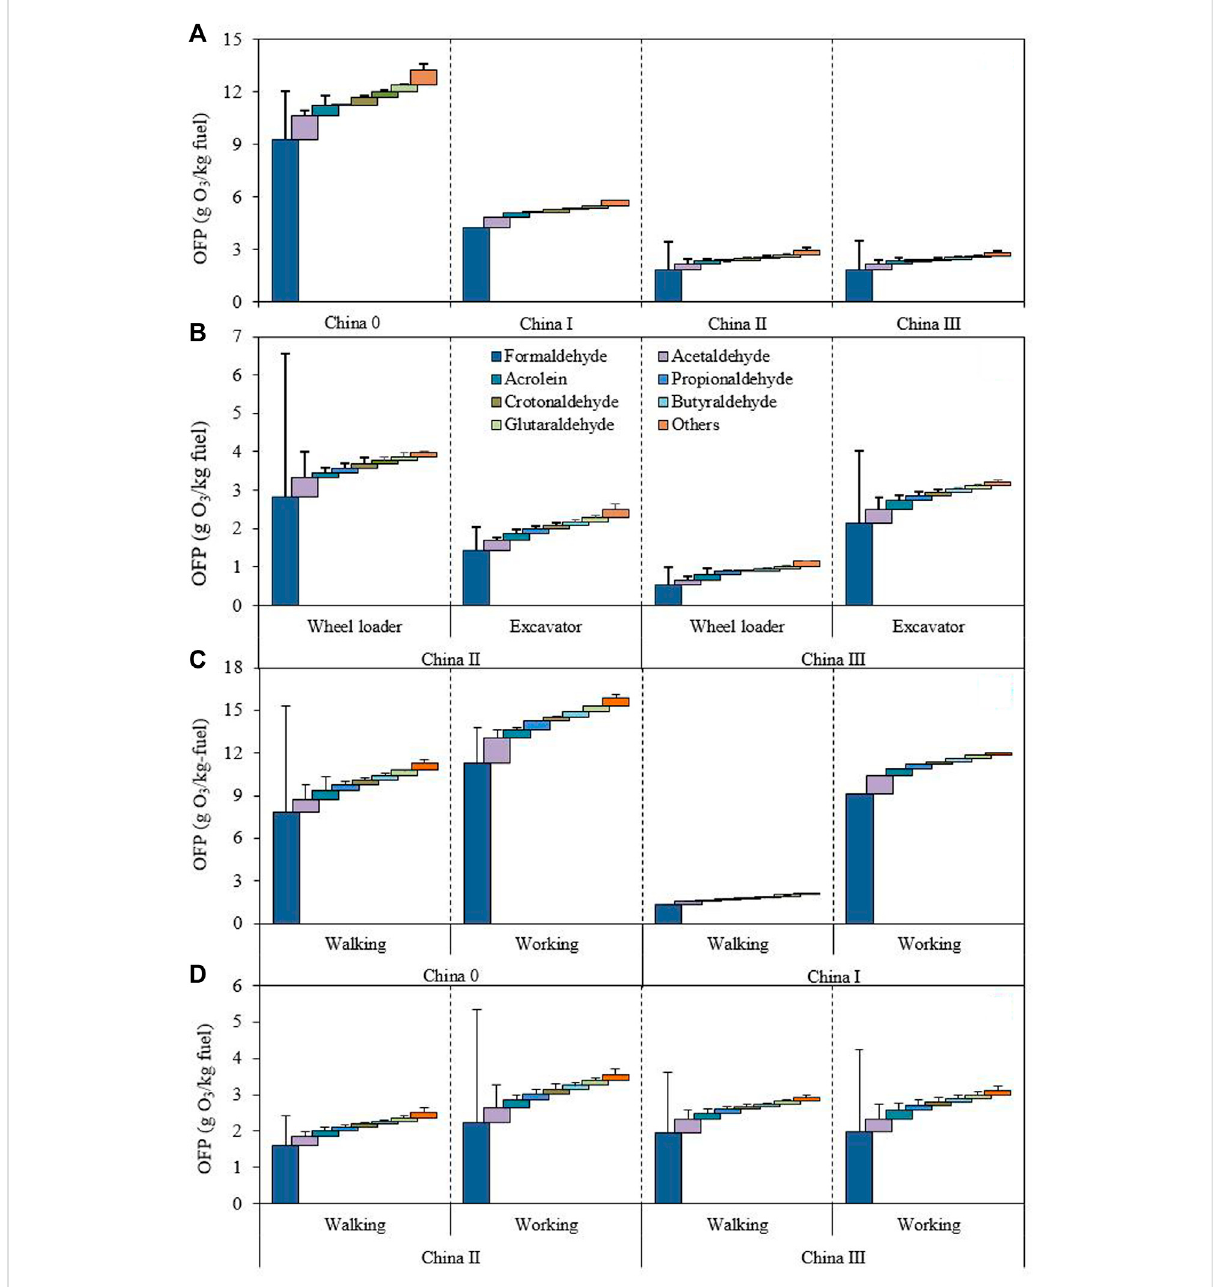
Contribution of each component to the OFP under the different emission standards (A) , machinery types (B) and working conditions (C,D)